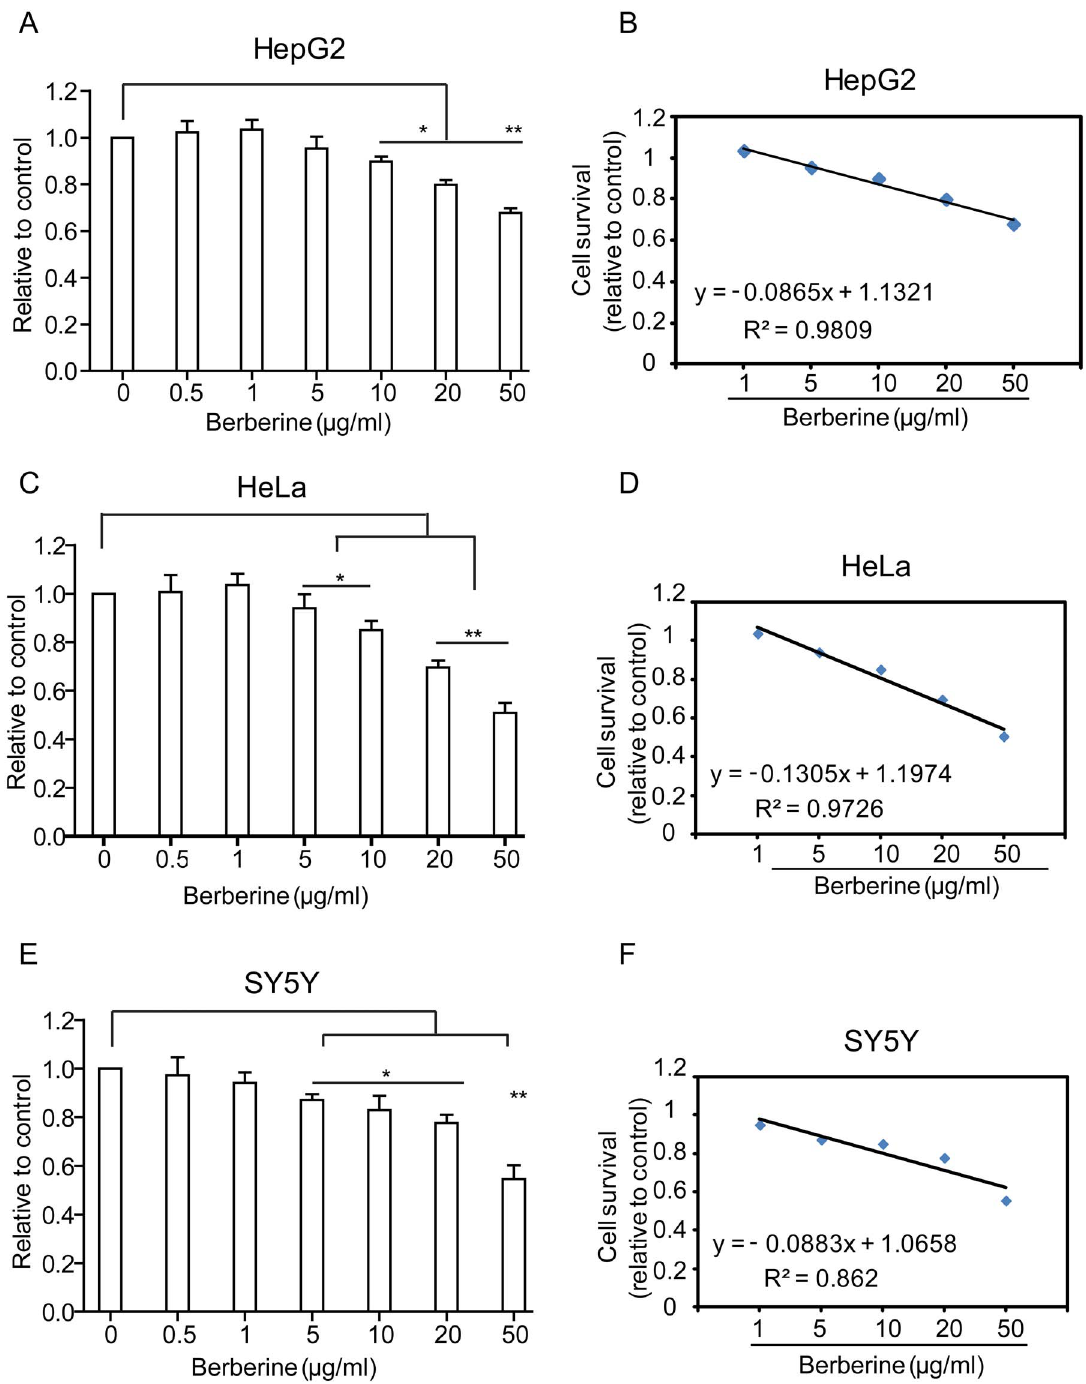
Figure 1. Cytotoxicity of berberine (BBR) in three cell lines. (A–F) The cytotoxicity and lethality of BBR using MTT assay. (A, B) HepG2, (C, D) HeLa. (E, F) SY5Y. * P , 0.05, ** P , 0.01, *** P , 0.005, statistical significance of BBR treated groups relative to control groups. Data are presented as mean 6 S.D. from six independent experiments (n=6).